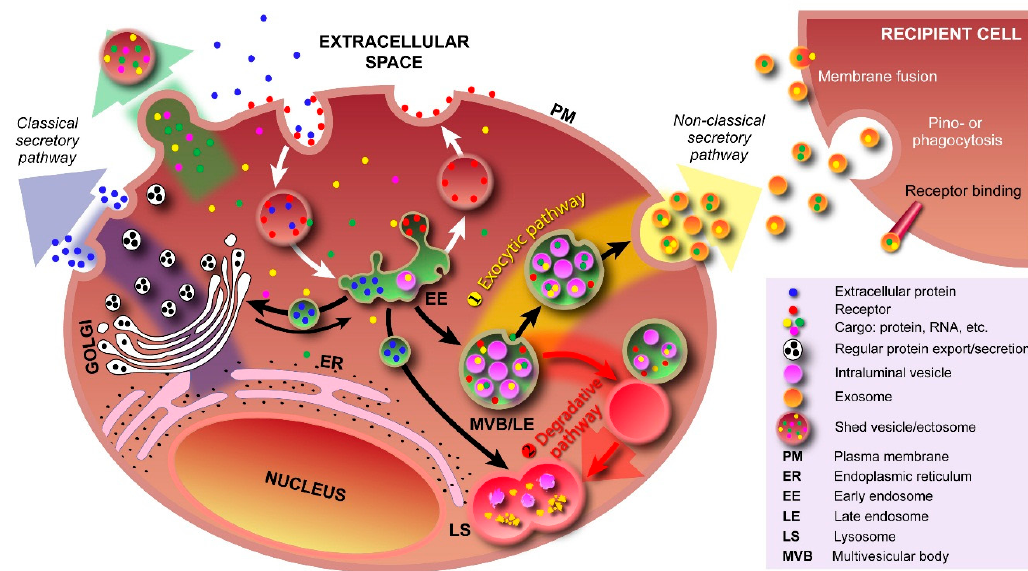
Figure 2. Pathways involving various types of vesicles. In the classical secretory pathway, vesicles with protein cargo, sorted and packed in the Golgi apparatus, transport their cargo to the plasma membrane (PM). By fusing with the PM, both membrane proteins and secretory proteins are effectively transported to their intended destinations. Various types of cargo, e.g., proteins, RNA, can also be transported into the extracellular space via outward PM budding and formation of shedded vesicles (ectosomes). Cargo is taken up by the cell via endocytosis (receptor-mediated and free uptake) and formation of early endosomes. In early endosomes, proteins are either recycled to the PM or sequestered into the intraluminal vesicles (ILV) of MVBs. Formation of exosomes starts with inward budding of the early endosome’s membrane and subsequent formation of MVBs. In the exocytic pathway ① , MVBs fuse with the PM to release their contents (exosomes) into the extracellular space; In the degradative pathway ② , the MVBs are trafficked to lysosomes for enzyme-assisted degradation. This pathway is particularly important for restricting signaling by activated growth factor receptors. Exosomal cargo delivery to the recipient cell can occur through various mechanisms, i.e. , direct fusion with the recipient cell’s membrane, pinocytosis/phagocytosis, or ligand–receptor binding.